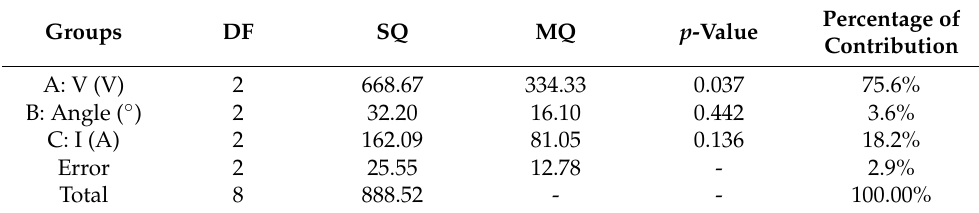
Table 10. Results obtained from ANOVA analysis for weld bead